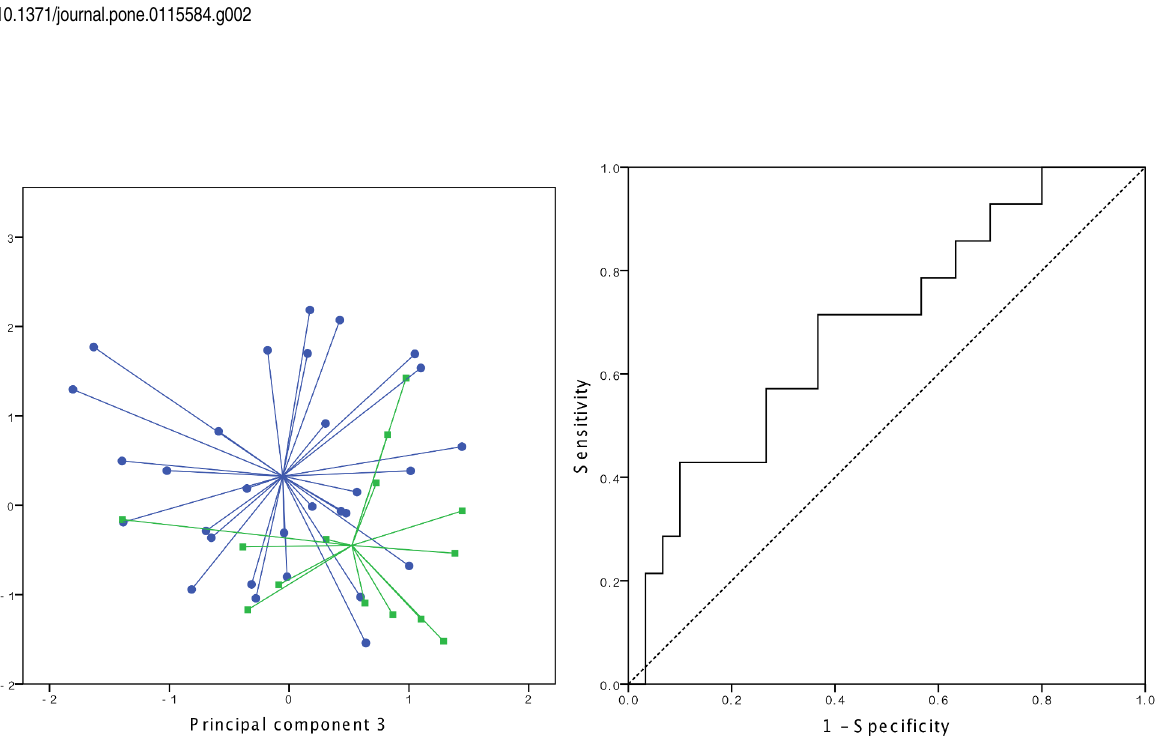
PLOS ONE | DOI:10.1371/journal.pone.0115584 December 26,